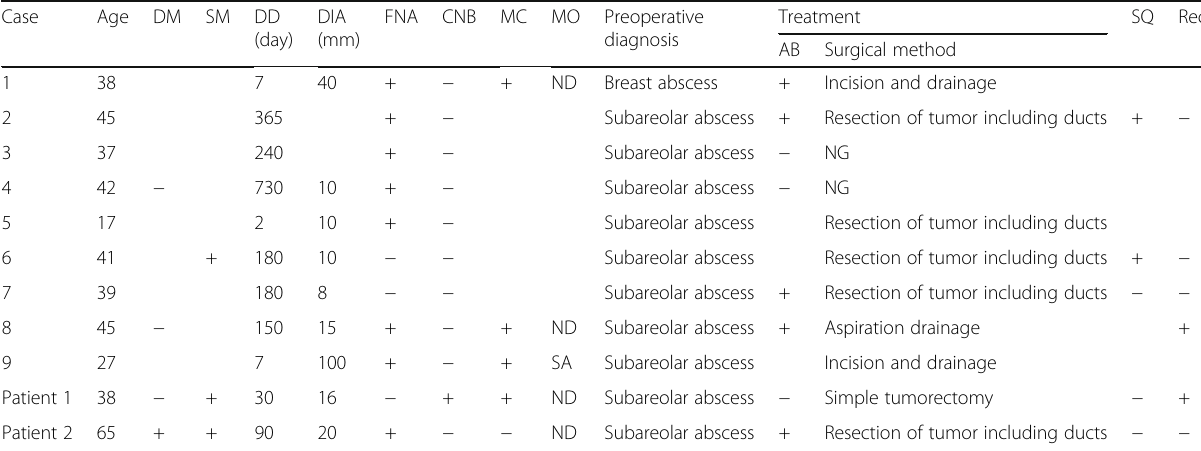
Table 1 Summary of reported cases